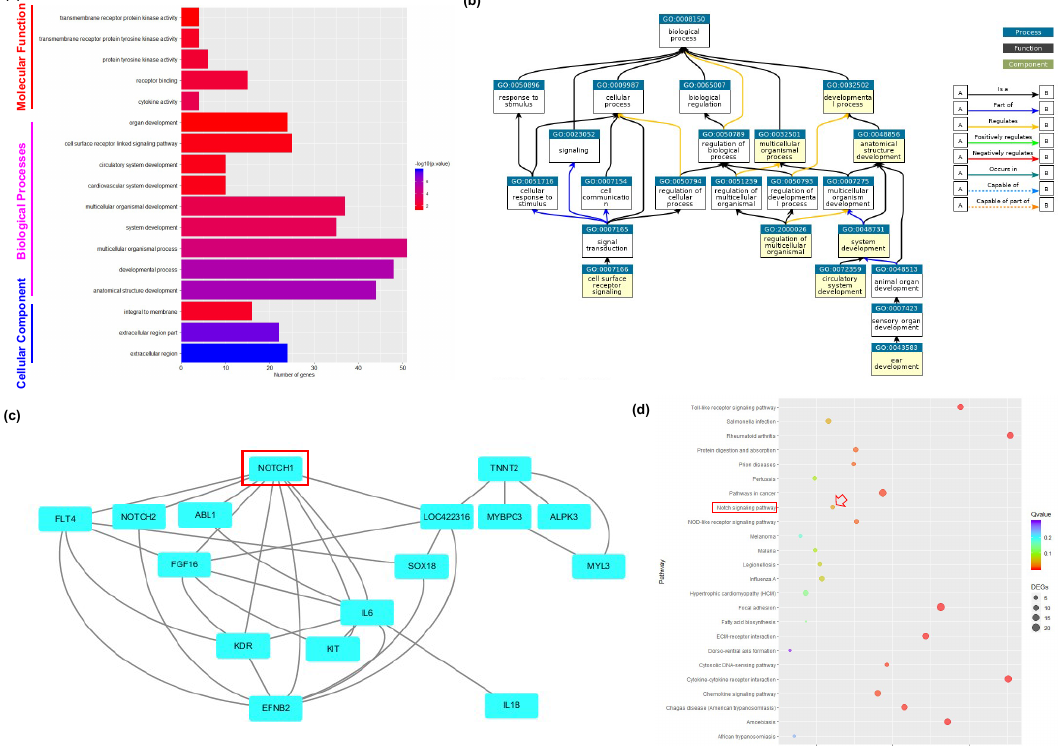
Figure 3. Enrichment analysis of DEGs in amphoteric PGCs in chicken. ( a ) Significant GO terms in amphoteric PGCs; ( b ) the directed acyclic graph (DAG) of biological processes (BP) GO term in amphoteric PGCs; ( c ) prediction of protein–protein interaction (PPI) relationship of DEGs in amphoteric PGCs; ( d ) the KEGG enrichment analysis of the DEGs in amphoteric PGCs. The red arrow points to the Notch signal.